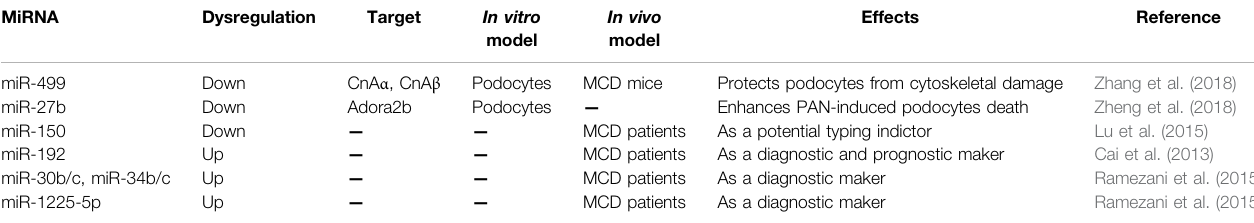
TABLE 2 | MiRNAs in minimal change disease.